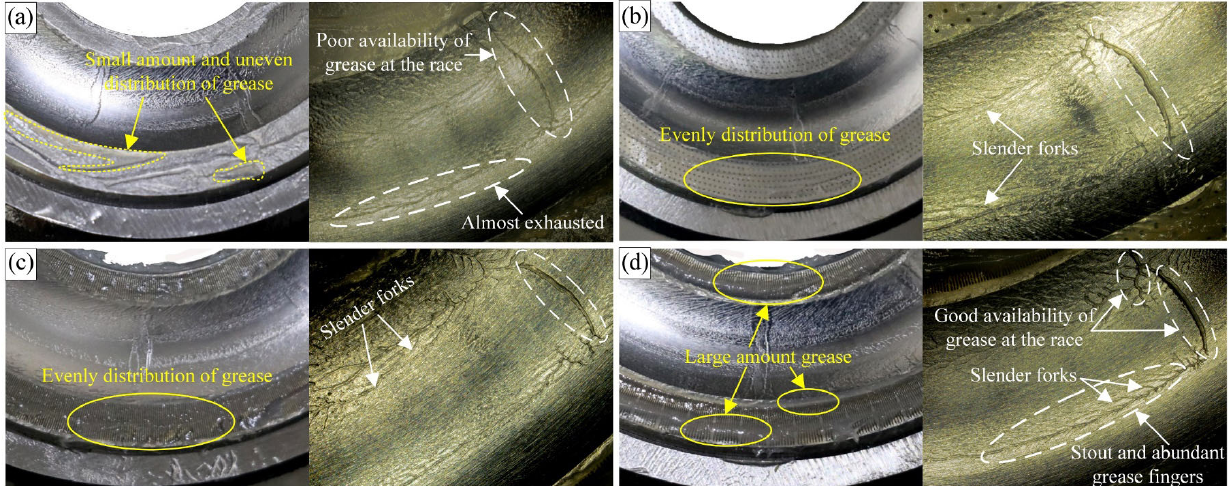
Fig. 13 Distribution of grease on guiding surface and raceway. (a) Non-textured, (b) dimple, (c) groove, and (d) gradient